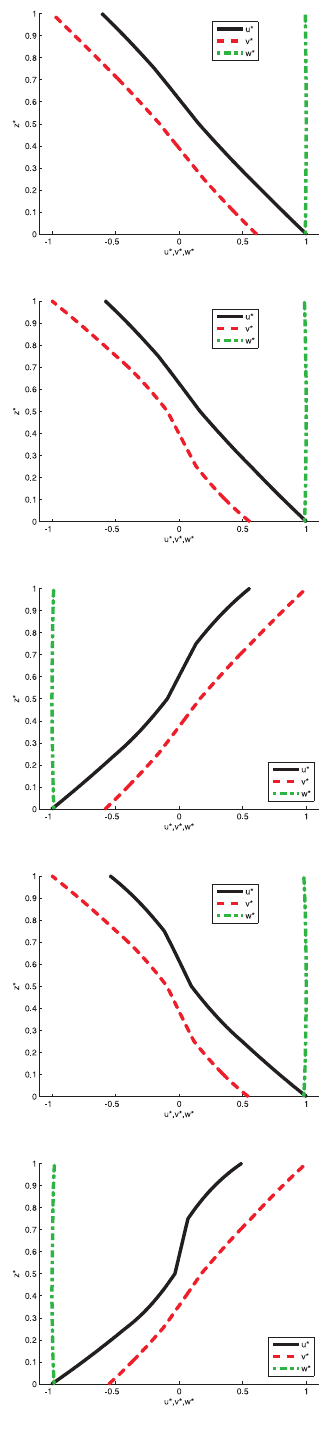
predictable. In this benchmark, the FE code does not give any in-plane frequency (see all the thickness ratios a/h).